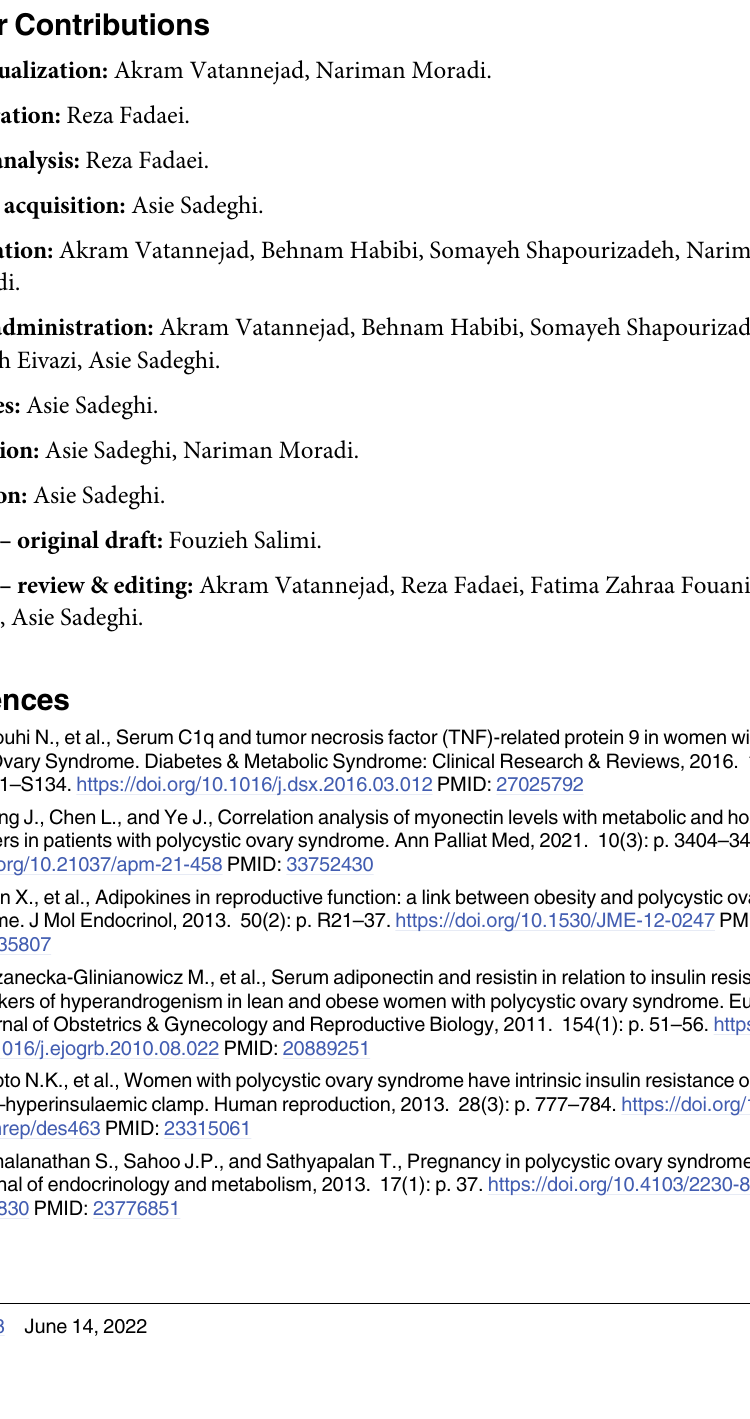
S1 Table. Clinical features of the whole